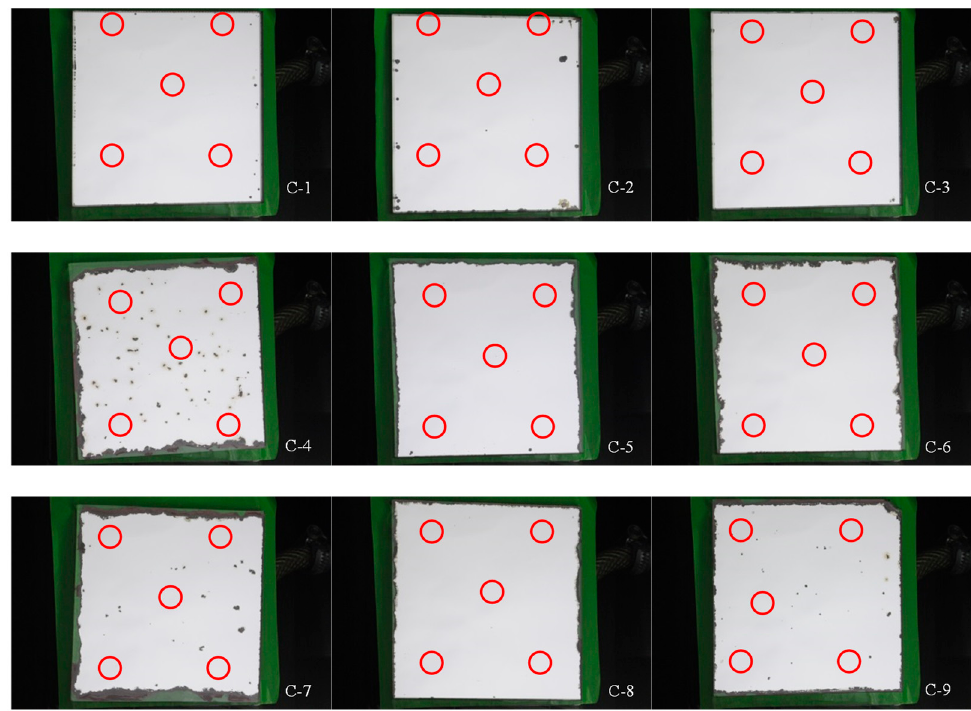
Figure 9. Images of the corroded reflector samples aged in the CASS test, with the measurement spots marked with red circles.